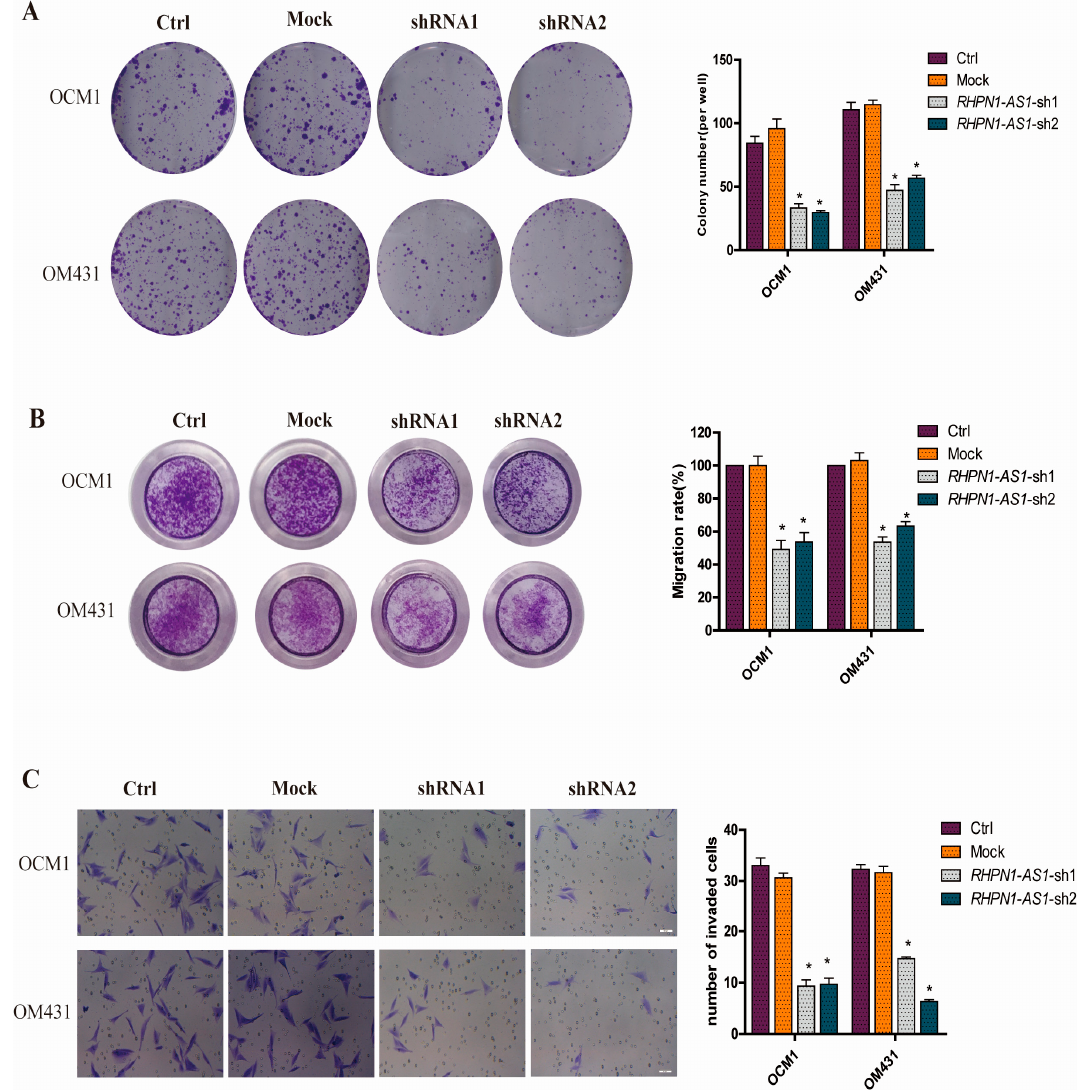
Figure 3. Knockdown of RHPN1-AS1 inhibits proliferation, migration and invasion of UM cells in vitro. ( A ) Colony formation assays were performed to evaluate the effect of RHPN1-AS1 on growth of UM cells after knockdown RHPN1-AS1 . * p < 0.05; ( B ) The effect of RHPN1-AS1 downregulation on the migration ability of OCM1 and OM431 cells was assessed using transwell assay. * p < 0.05; ( C ) Effects of RHPN1-AS1 knockdown on the invasion potency of OCM1 and OM431 cells were detected using matrigel invasion assay. The scale bars represent 50 µm. * p < 0.05.